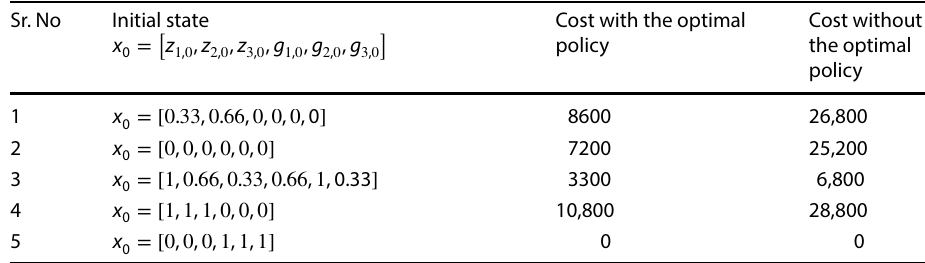
Table 2 C omparison of Cost (E qu . 20 ) with samplE trajECtoriEs of lEngth 20 dECision EpoChs